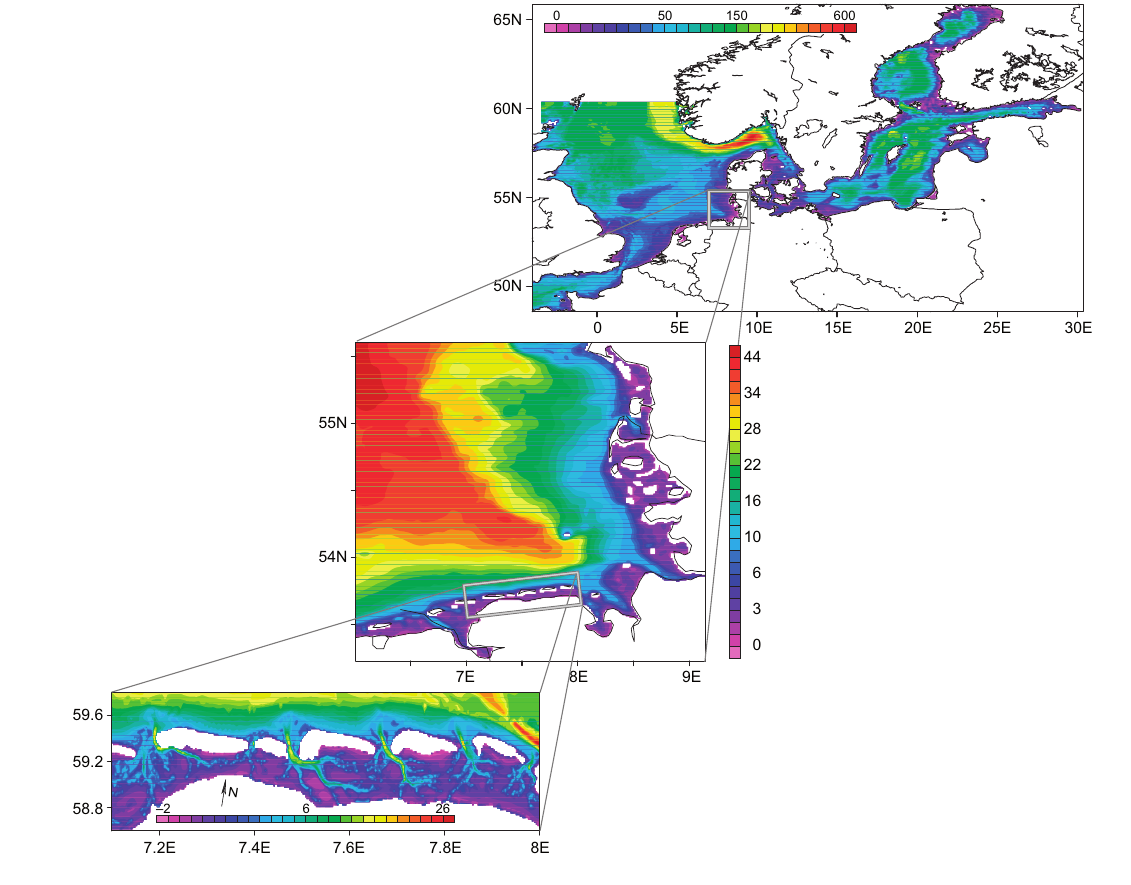
Fig. 6. Nested modelling system for the German F IG . 6. Nested modelling system for the German Bight.